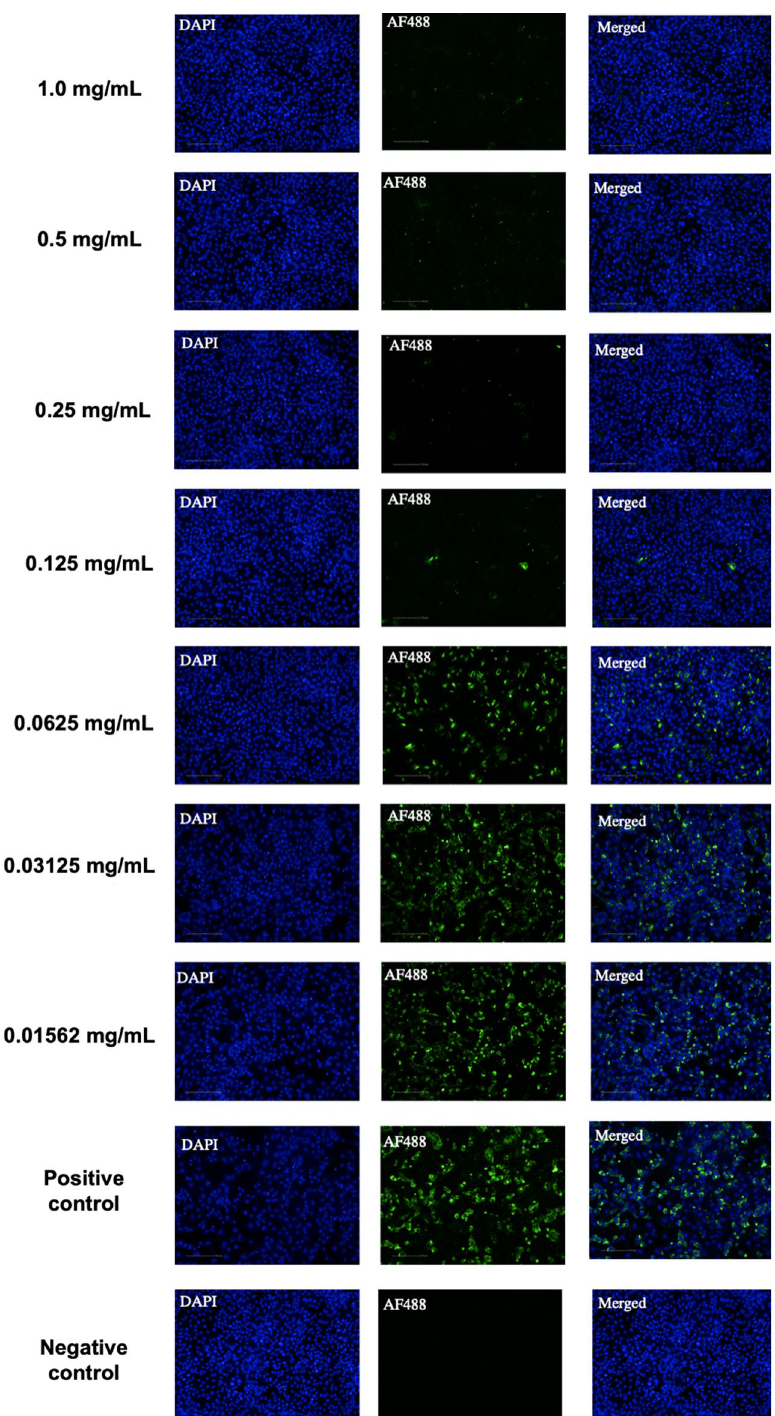
Figure 1. Indirect immunofluorescence (IIF) assay for the detection of SARS-CoV-2-infected cells. Representative images of the noncytotoxic concentrations (1.0 mg/mL up to 0.156 mg/mL) of APD observed with a 20 × objective. A mixture of MERS-CoV-infected and noninfected Vero cells was stained with convalescent serum monoclonal antibodies, followed by incubation with the Alexa488-conjugated goat anti-human IgG antibodies (green). Cells were counterstained with DAPI to stain the nuclei (blue). Positive (infected nontreated cells) and negative (noninfected cells) controls are shown at the bottom of the image. Images were taken using the Operetta High Content Imaging System (Perkin Elmer). Scale bar, 100